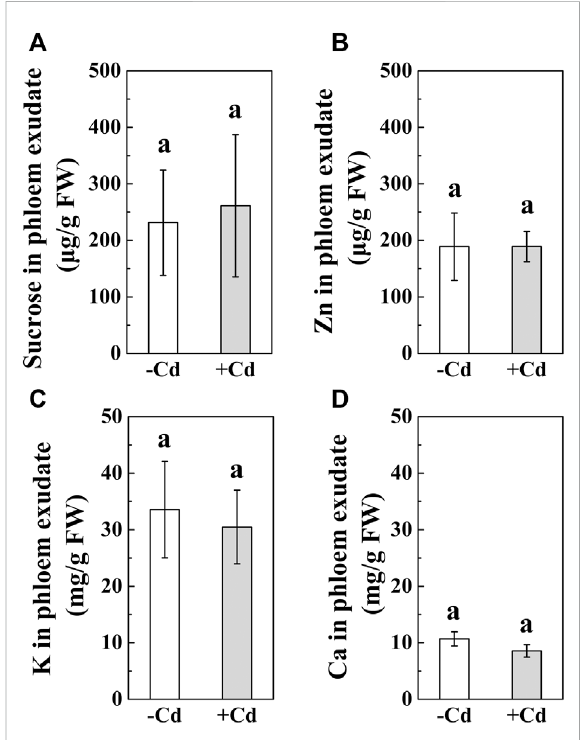
FIGURE 3 Sucroseandelementsinthephloemexudatescollectedfrom leaves of 6-week-old S. alfredii after being treated with 0 or 100 μ mol · dm ⁻ ³ CdCl 2 for 14 days. (A) Sucrose concentration. (B) Zn concentration. (C) K concentration. (D) Ca concentration. Data are shown as means ± SD (n = 4). Different letters indicate signi fi cant differences between the control and Cd-treated plants ( t -test, p < 0.01). FW, fresh weight.